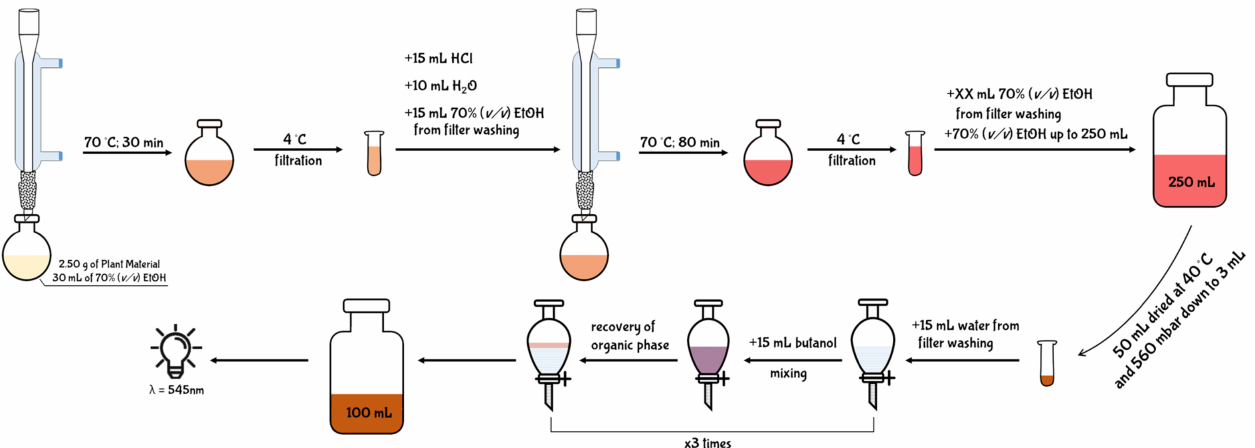
Figure 9. Schematic representation of the Pharmacopoeia Method employed for the quantification of PACs from Cratae- gus